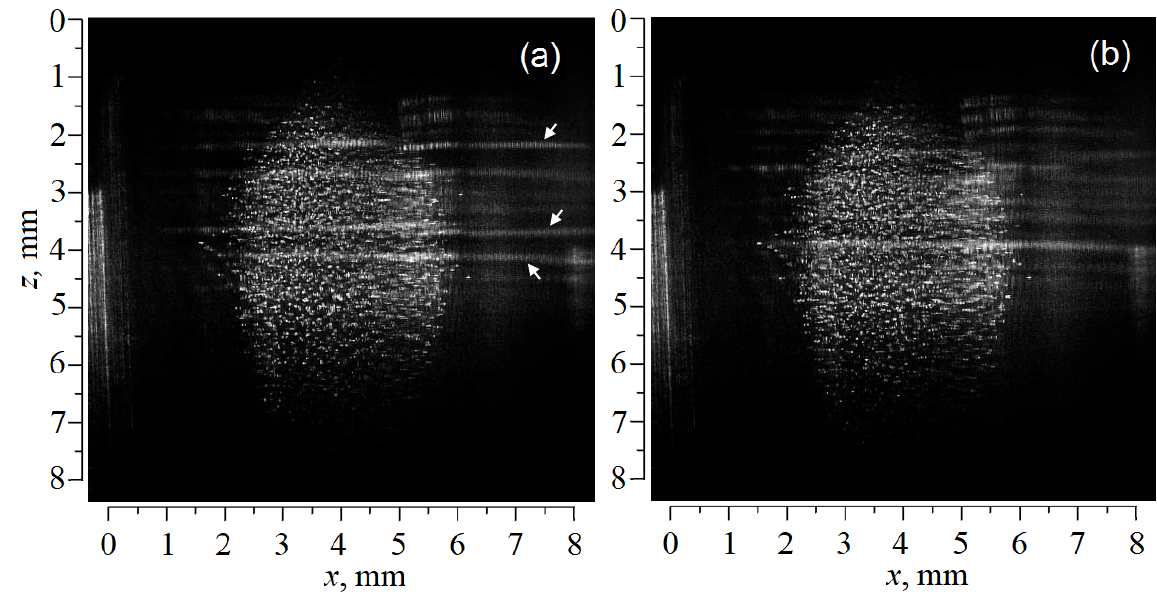
Figure 2. Dust cloud in the DC discharge stratum containing a mixture of the CeO 2 particles and condensed submicron particles formed 20 min after the start of the experiment;( a ) t = 0; ( b ) t = 30 ms. The positions of large-amplitude wave crest are indicated by arrows.